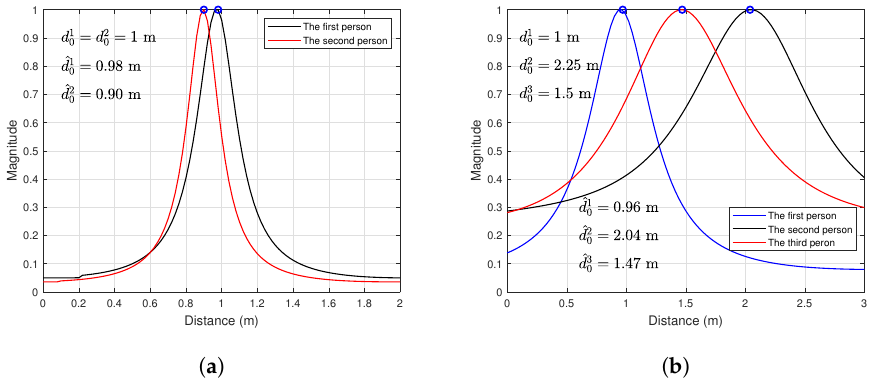
Figure 10. Estimated distance of multiple persons. ( a ) For two persons at the same distance from the radar. ( b ) For three persons at different distances from the